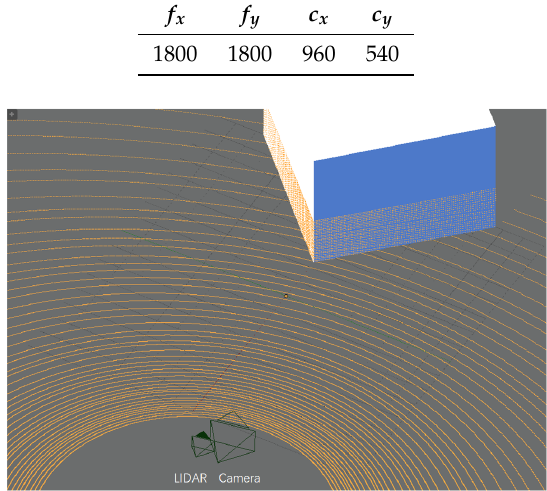
Table 1. Intrinsic parameters of virtual camera.